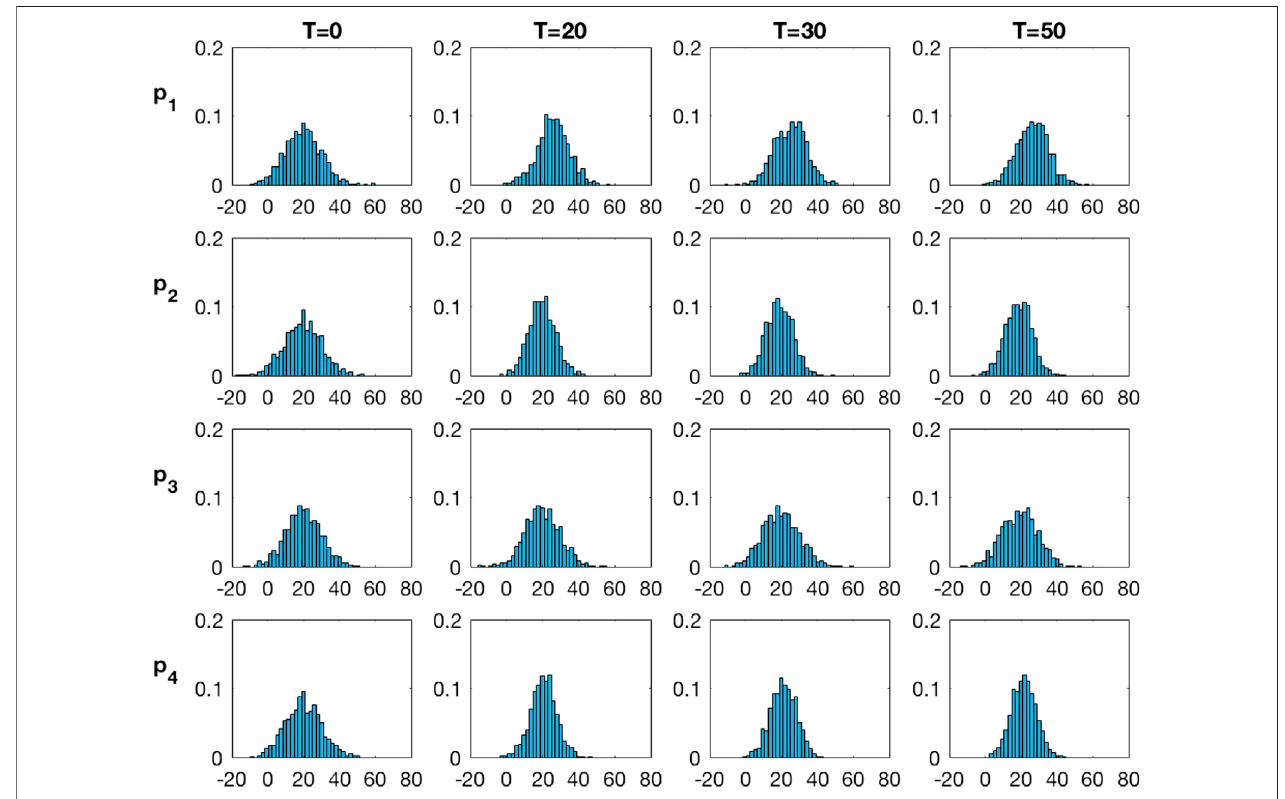
FIGURE 9 | Marginal pdfs at monitoring locations for increasing current time T from the inversion with the traditional Kalman model.